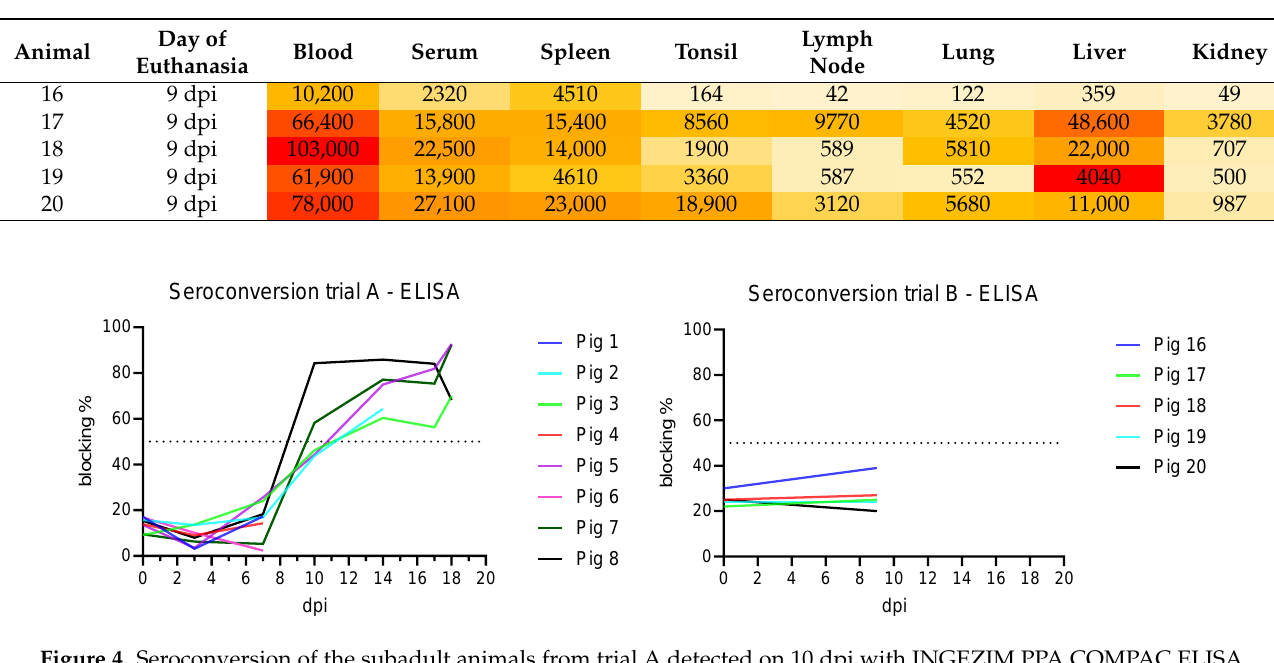
Table 5. Trial B: real-time PCR results of blood, serum and organ samples at the day of euthanasia. Genome detection in blood, serum, and organs are presented as genome copies per run (5 µ L). The color depth indicates the level of the viral load. From white to red indicates from low to high viral load.